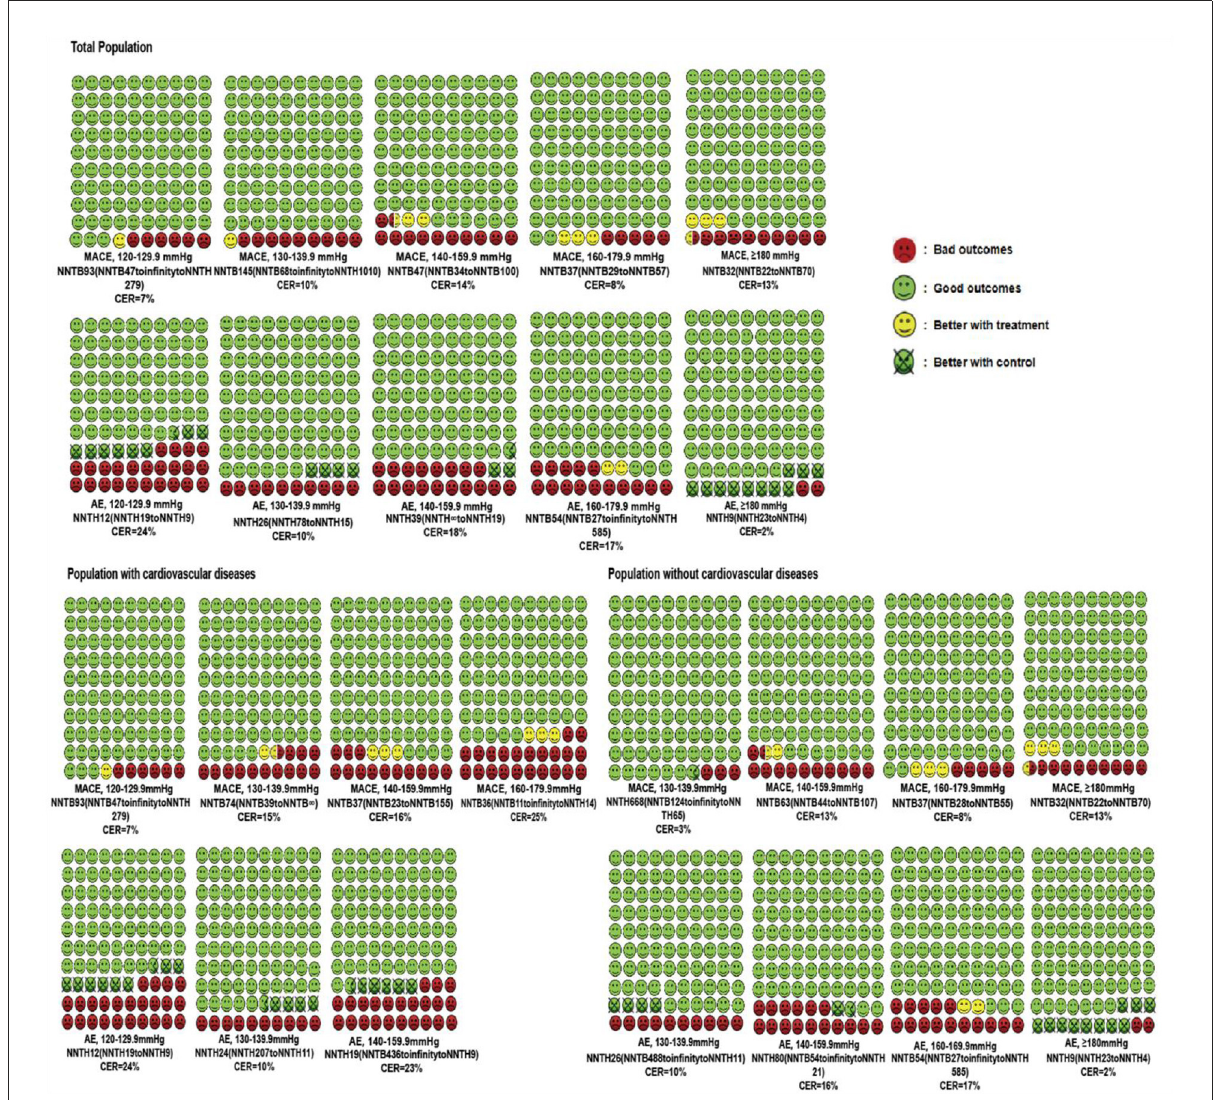
FIGURE2 Cates plot of the NNTs for primary outcomes across different SBP levels and cardiovascular diseases status. Each region is the value of NNT of MACEs or AEs in one SBP level and includes 100 faces corresponding to the patients treated with antihypertensive medication. Green faces mean patients not occurring MACEs or AEs with the treatment. Red faces indicate that patients presenting MACEs or AEs with the treatment. Yellow faces represent patients that would not have MACEs or AEs if they would be treated with the treatment. Crossed green faces present patients not fulfilled MACEs or AEs with a control group. Mean follow-up duration was 3.50